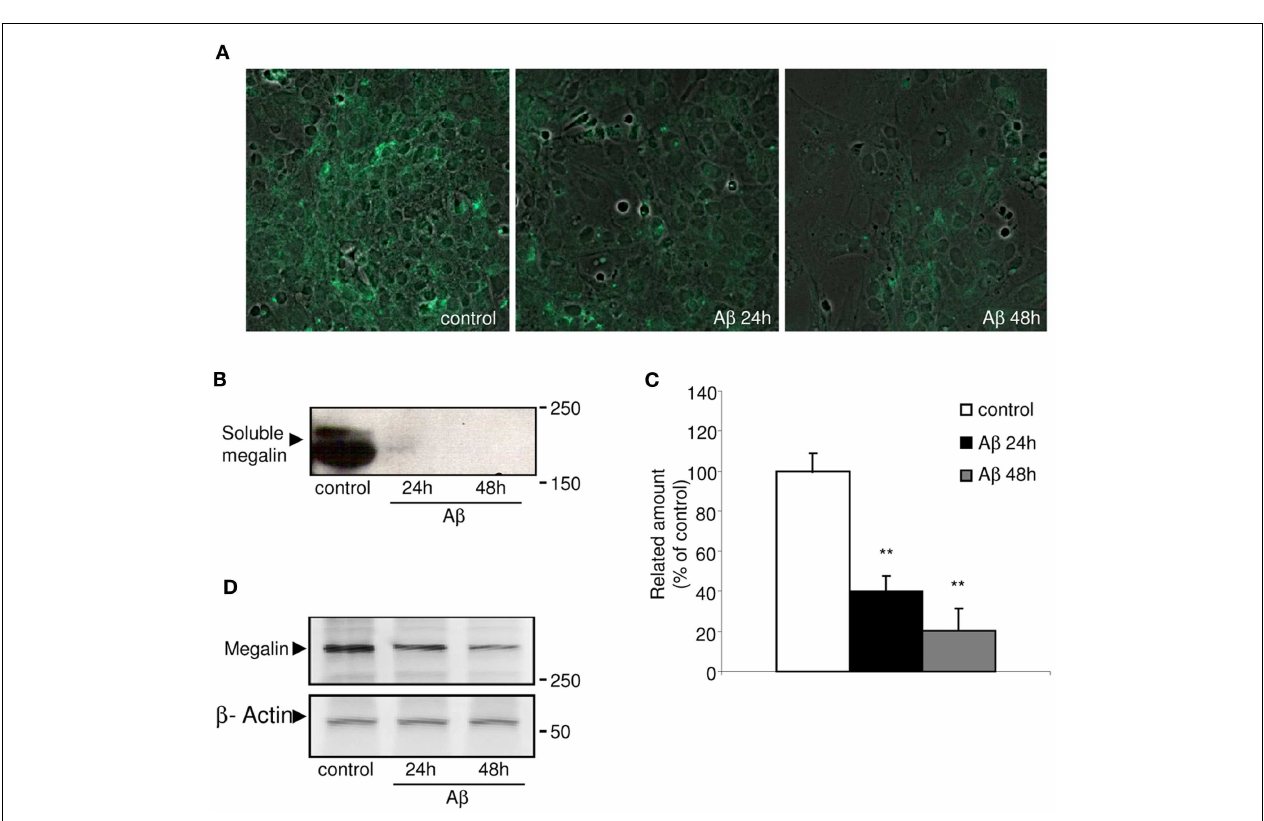
and the amount of extracellular megalin after A β 40 treatments was measured onWestern blots. (C) The histogram represents densitometric values from three replicates. (D) A representativeWestern blot showing reduced expression of membrane-bound megalin in cell lysates following A β 40 treatment for 24 and 48h. Results are expressed as mean ± SEM. ** p <